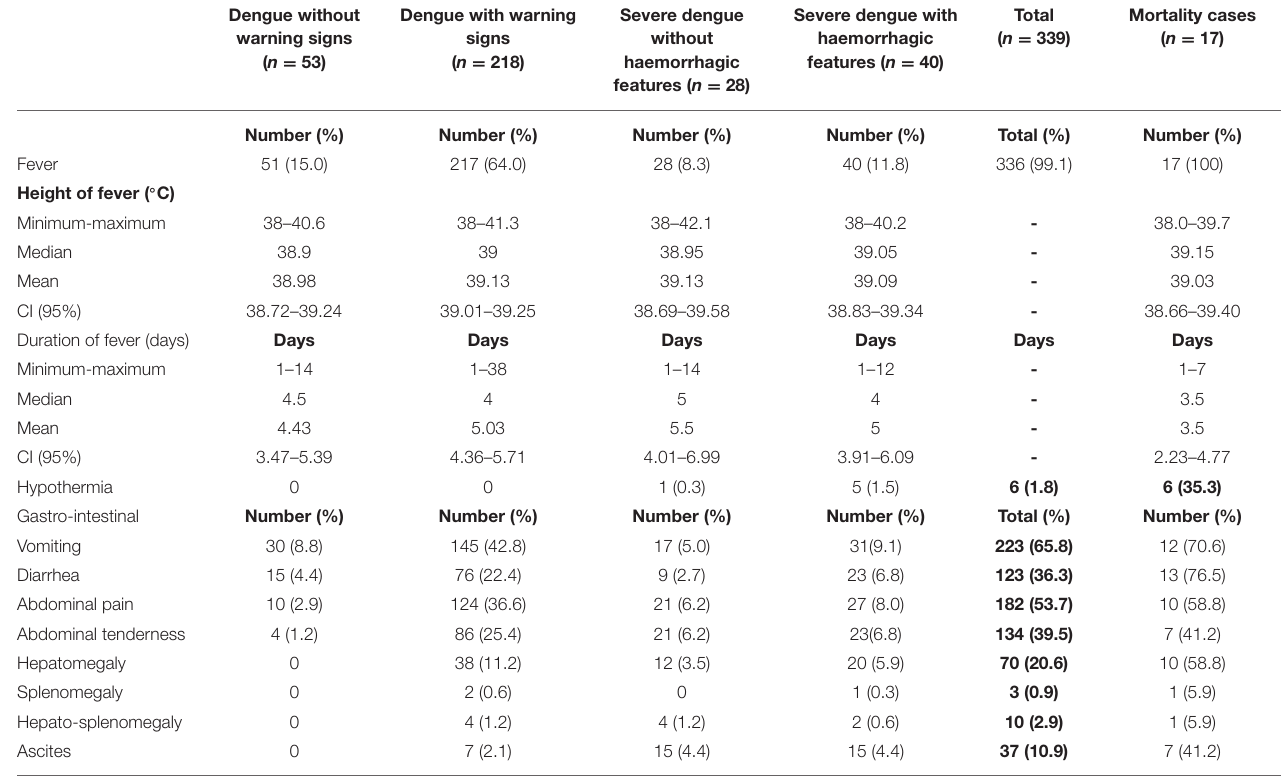
TABLE 3A | Clinical manifestations in pediatric patients hospitalized with suspected and confirmed dengue in the 2018-2019 epidemic.